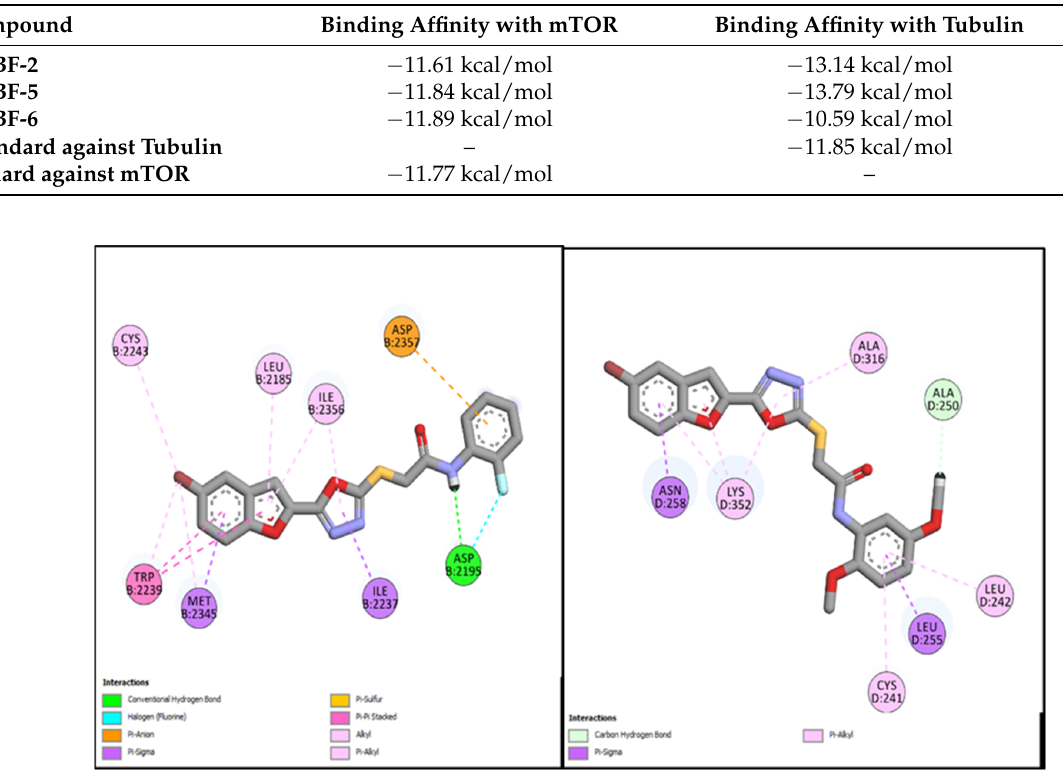
Table 5. Binding affinities of BF-2, BF-5, and BF-6 with mTOR and Tubulin.